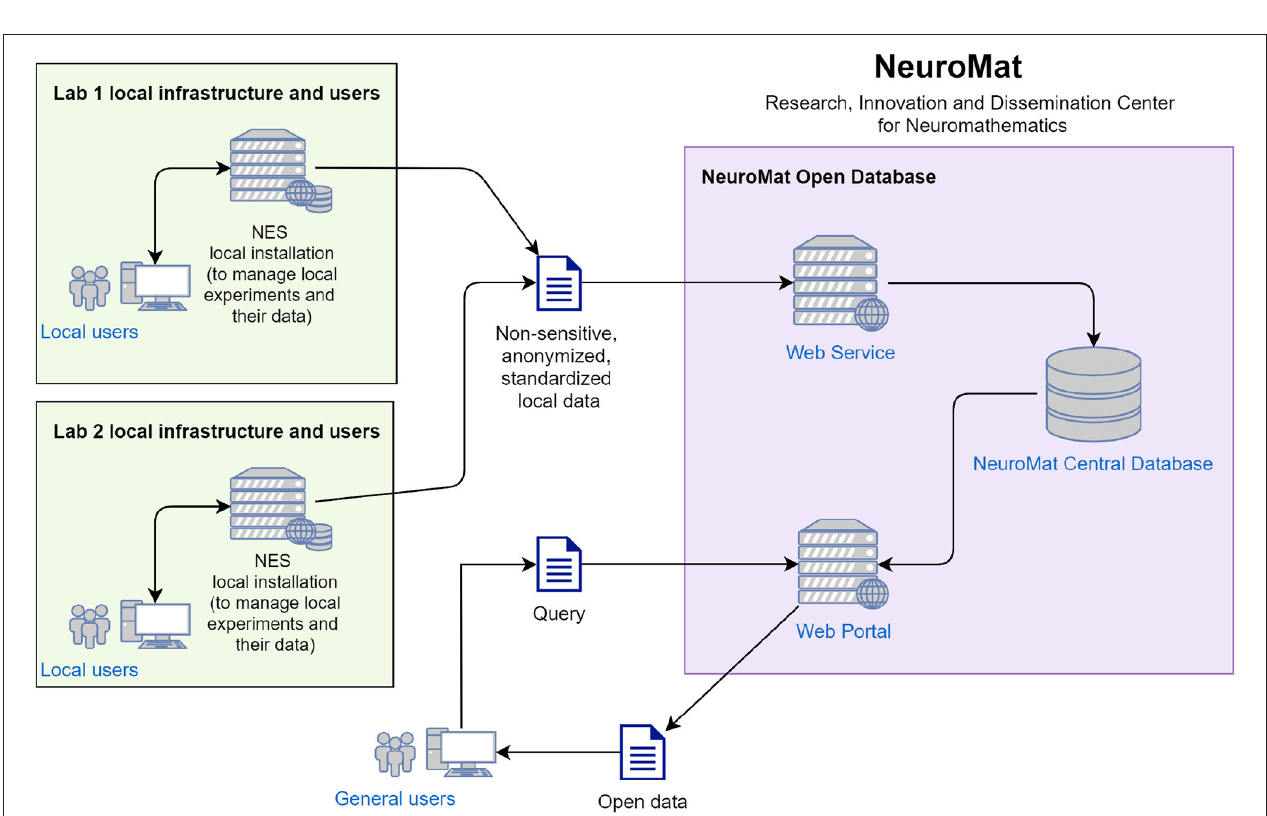
FIGURE 14 | Data capture with NES and public sharing in the NeuroMat Open